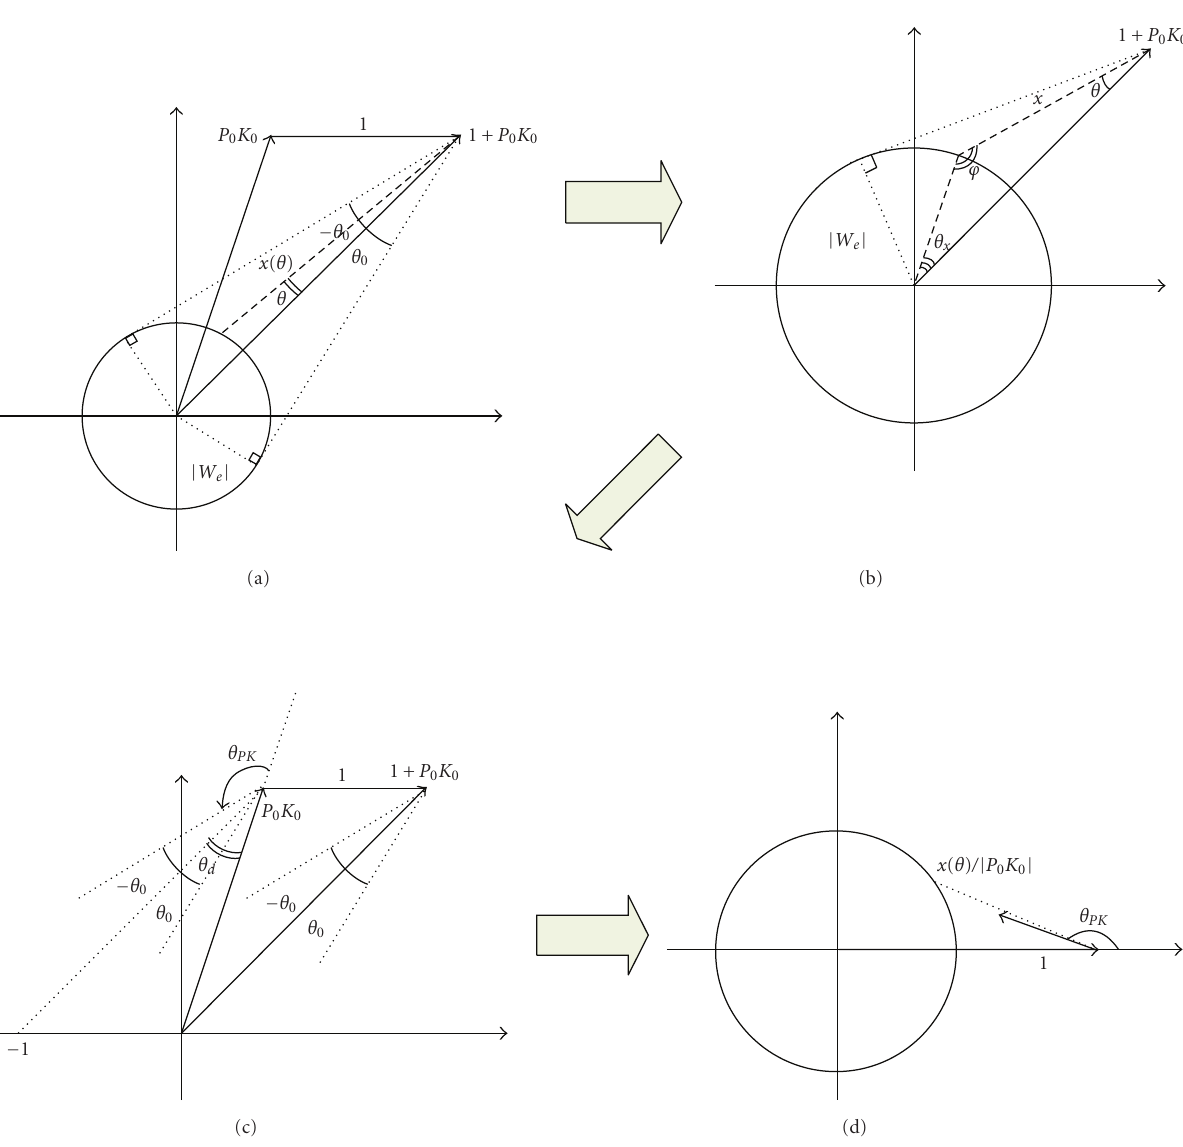
Figure 4: (a) The critical range for maximum possible magnitude verification, (b) limit calculation regarding θ , (c) angle conversion, and (d) geometric transformation after